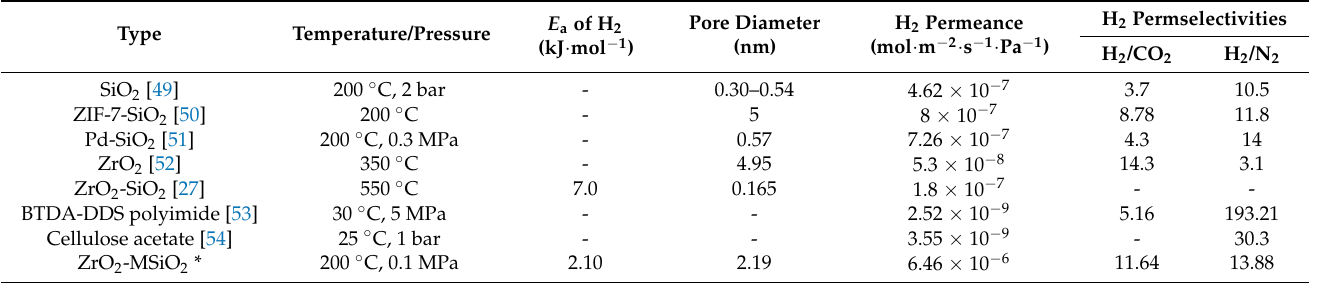
Table 3. E a of H 2 , pore diameter, H 2 permeance, and H 2 permselectivities for various